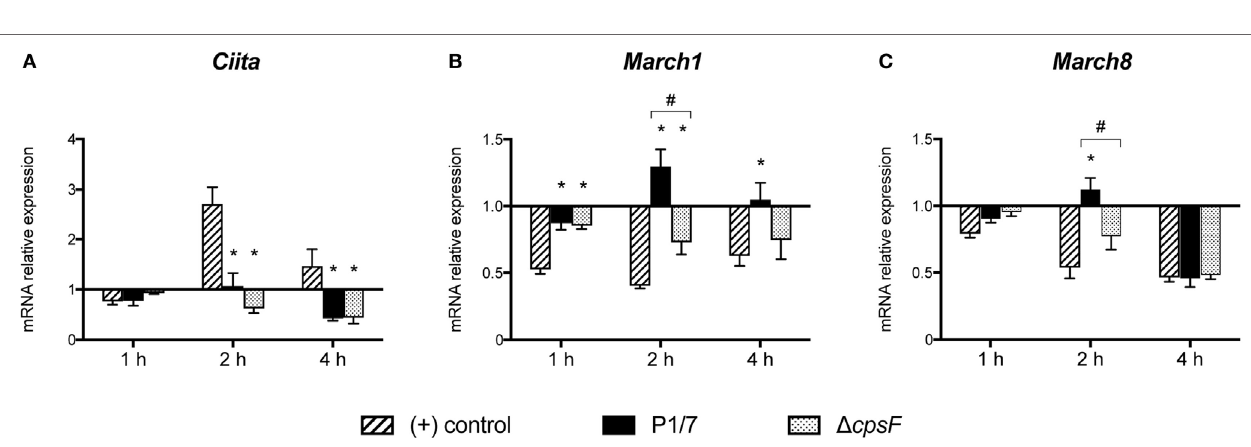
FigUre 3 | Naïve splenic dendritic cells (DCs) show low intensity of MHC-II expression upon in vitro stimulation with the encapsulated strain of Streptococcus suis . Spleen cells from a pool of 10 naïve C57BL/6 mice were FACS-purified and CD11c + cells (APC-conjugated anti-CD11c) were sorted with the BD FACSAria ™ Fusion flow sorter as illustrated in (a) . (B) Purified cells were stimulated for 2, 4, or 18 h with S. suis wild-type (WT) strain P1/7 or the non-encapsulated mutant Δ cpsF (initial MOI:1). Unstimulated cells served as negative ( − ) control for basal expression at each time point. Cells stimulated with lipopolysaccharide (LPS) (1 µg/ml) were used as positive ( + ) control. Cells were harvested and surfaced stained for CD86 or MHC-II. Representative density plots have been selected for this figure (at time = 18 h). Histograms of MHC-II expression (gated on CD11c + cells) have also been included to illustrate variations in the mean fluorescence intensity (MFI) of the MHC-II high population (P2, at time = 18 h). Data analysis was performed using FACSDiva software. Density plots were drawn based on APC- and PE-control stains and plotted on logarithmic